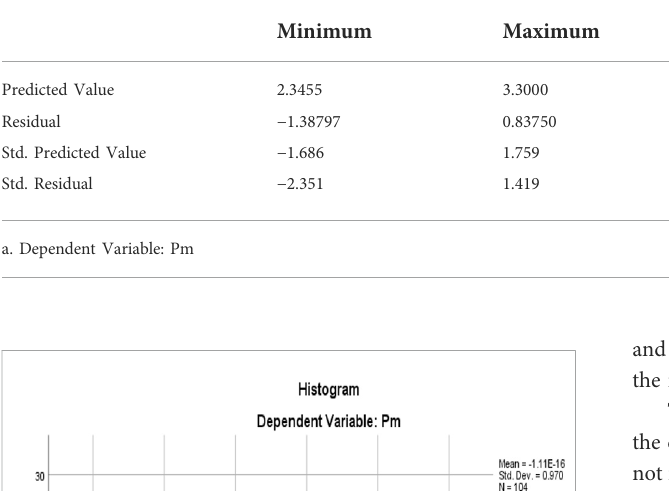
TABLE 11 Residual statistics corresponding to the dependent variable for Pm.